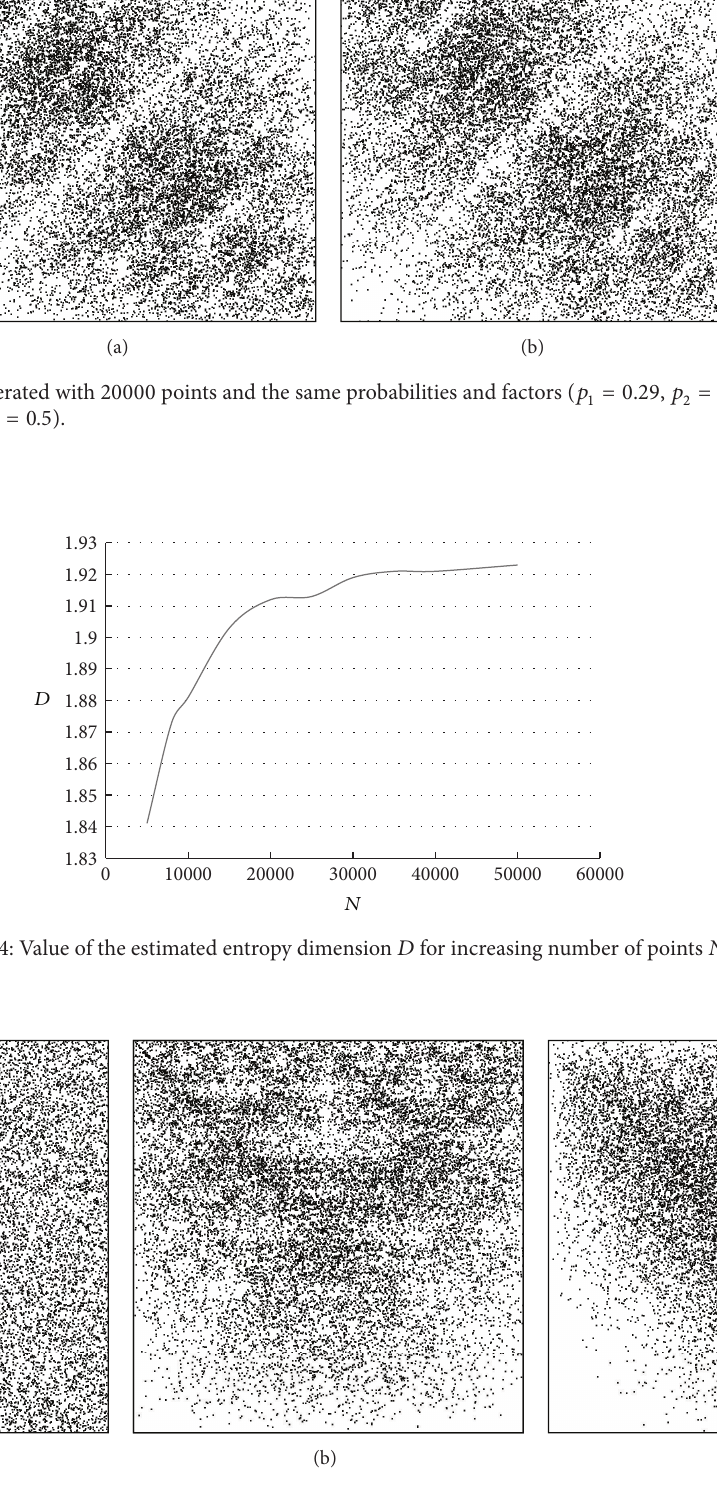
Figure 5: Distributions generated with 20000 points, the same probabilities, and different